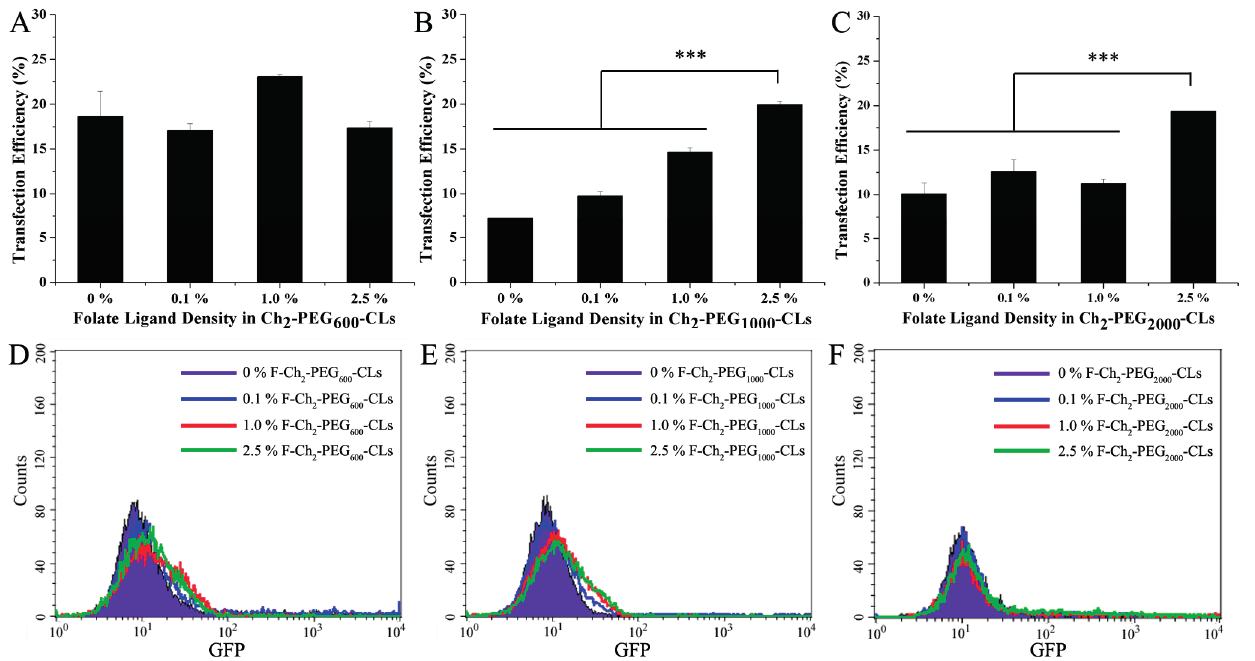
Figure 5. The effect of folate ligand densities in F-Ch 2 -PEG n -CLs on transfection efficiencies (mean ± SD, n = 3, *** p < 0.001). ( A – C ) The transfection efficiencies